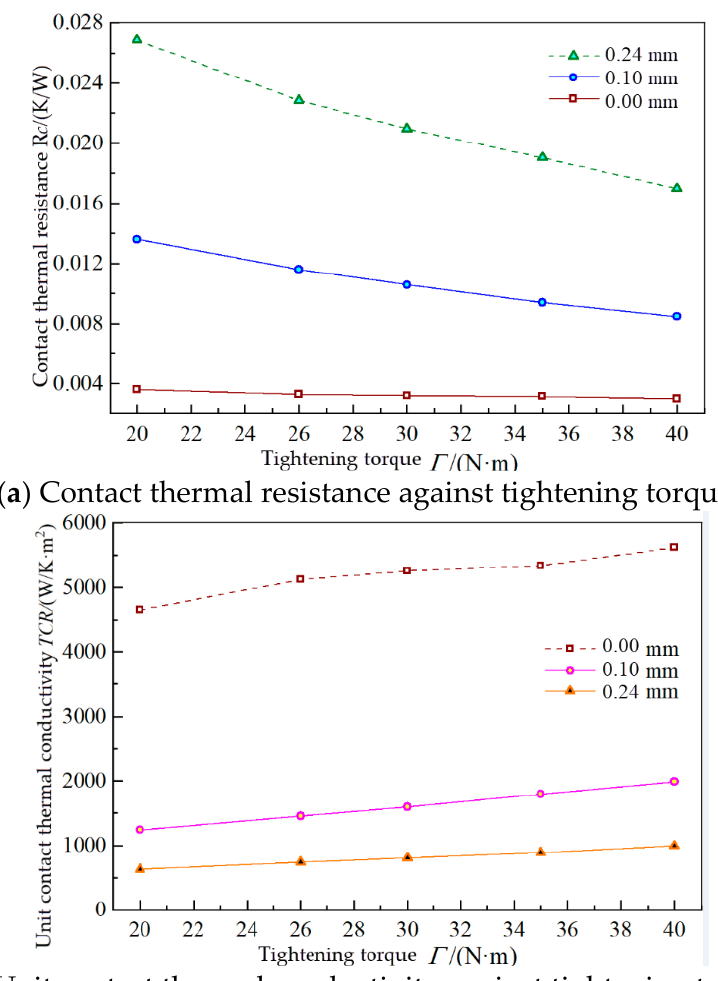
Figure 15. Effect of tightening torques with contact thermal resistance and thermal conductivity at different flange clearances for the 304 stainless steel – Q345R material.